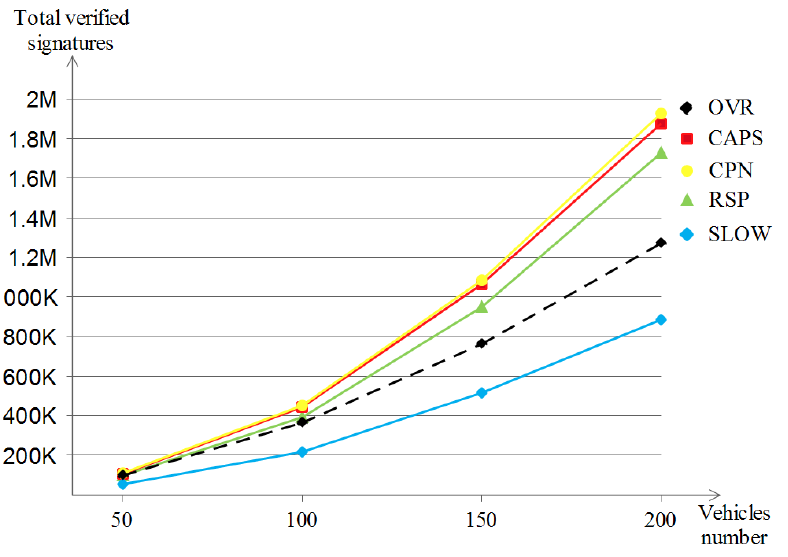
Figure 19. Verified signatures number of privacy schemes in the Manhattan